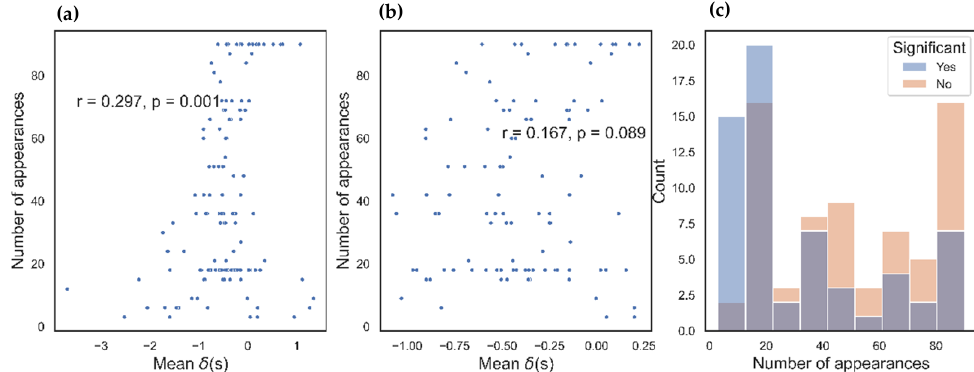
Figure A4. ( a ) This panel presents the correlation between the number of scores and the mean object-based dynamic score. ( b ) This panel presents the correlation after removing dots that are 1SD higher or lower than the mean. ( c ) This panel presents histograms of the number of scores for sets of significant and non-significant words.